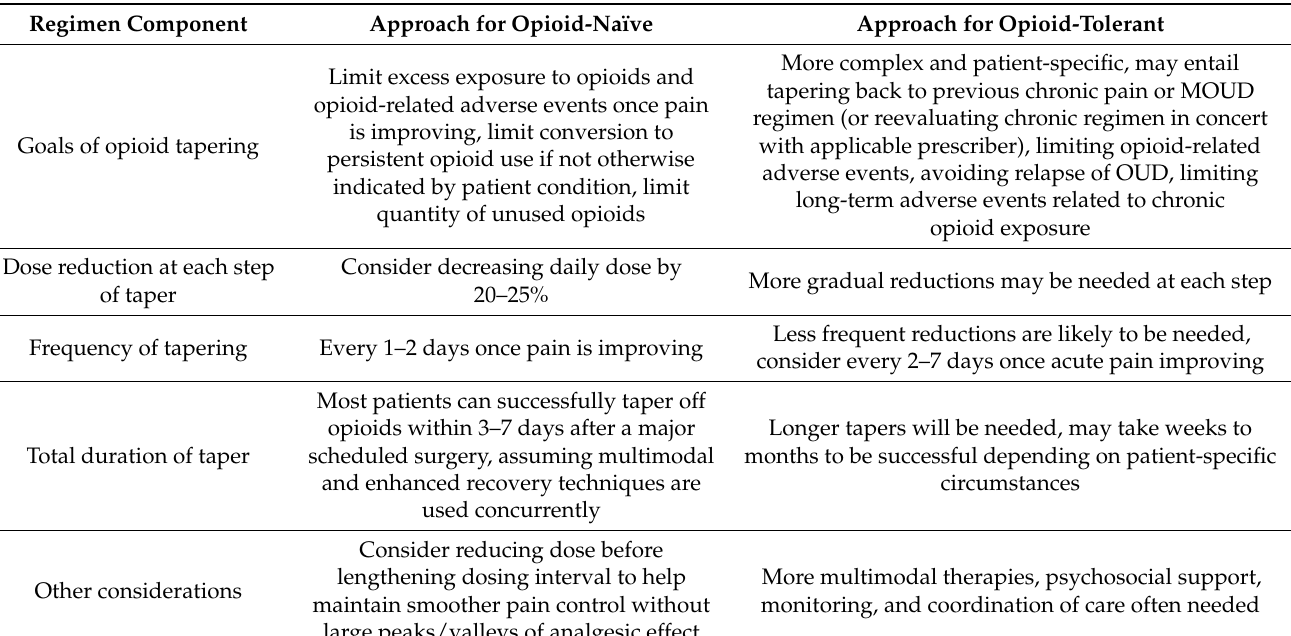
Table 4. Recommended considerations for tapering opioid regimens after acute painful